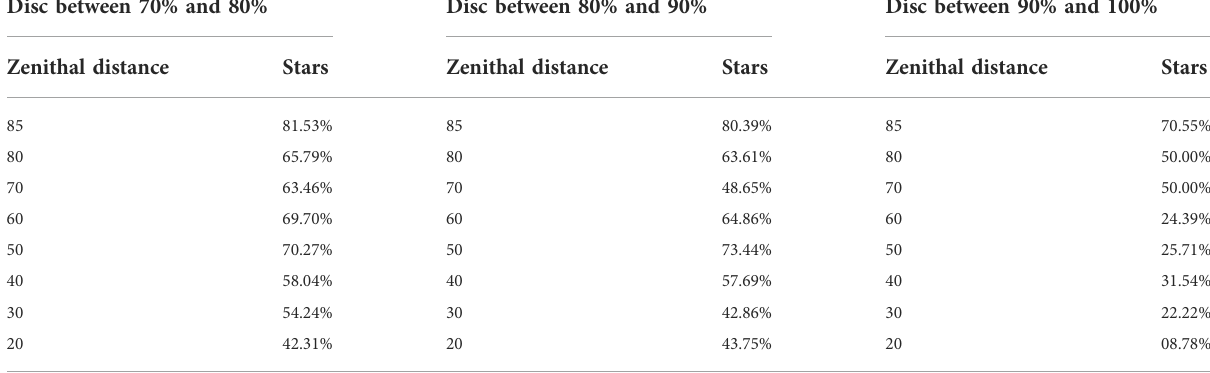
TABLE 3 Percentages of stars found as a function of the lunar disk and zenith distance from the Moon. Disc between 70% and 80% Disc between 80% and 90% Zenithal distance Stars Zenithal distance